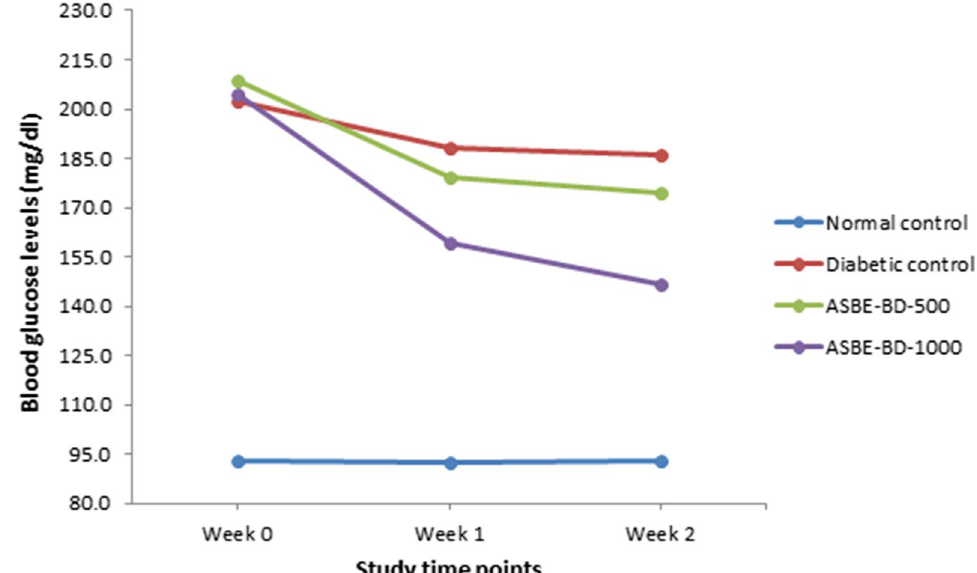
Fig. 2 A profile plot showing groups’ mean scores in blood glucose levels at week 0, week 1 and week 2 of the study